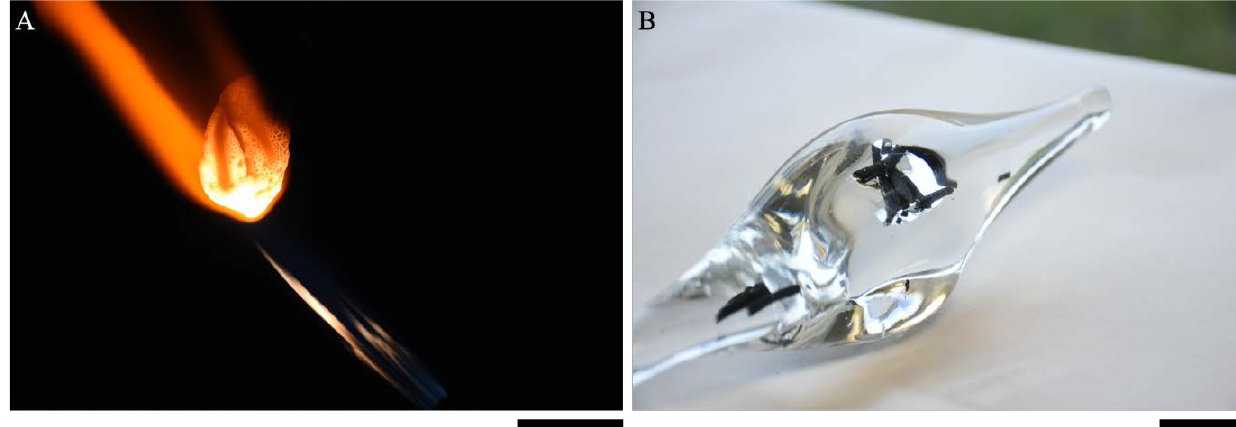
Figure 10: The results of experimentation with volcanic materials at a 2019 ‘In Vulcan’s Forge’ workshop held at the National Glass Centre, Sunderland, U.K. [A] An example of lamp- or flame-work with obsidian, showing the surface evidence for bubble formation and growth that is inevitable at high temperatures when a pre-processing step is not taken (c.f. Figure 6). [B] Fragments of basalt trapped in soda-lime-silica glass, showing the apparent lack of evidence for serious incompatibility between volcanic materials and standard glasses (c.f. Table 1), which would manifest as fractures formed during cooling and annealing. The scale bars in the bottom right of the images represent 1 cm, and are indicative (note that [B] is a perspective